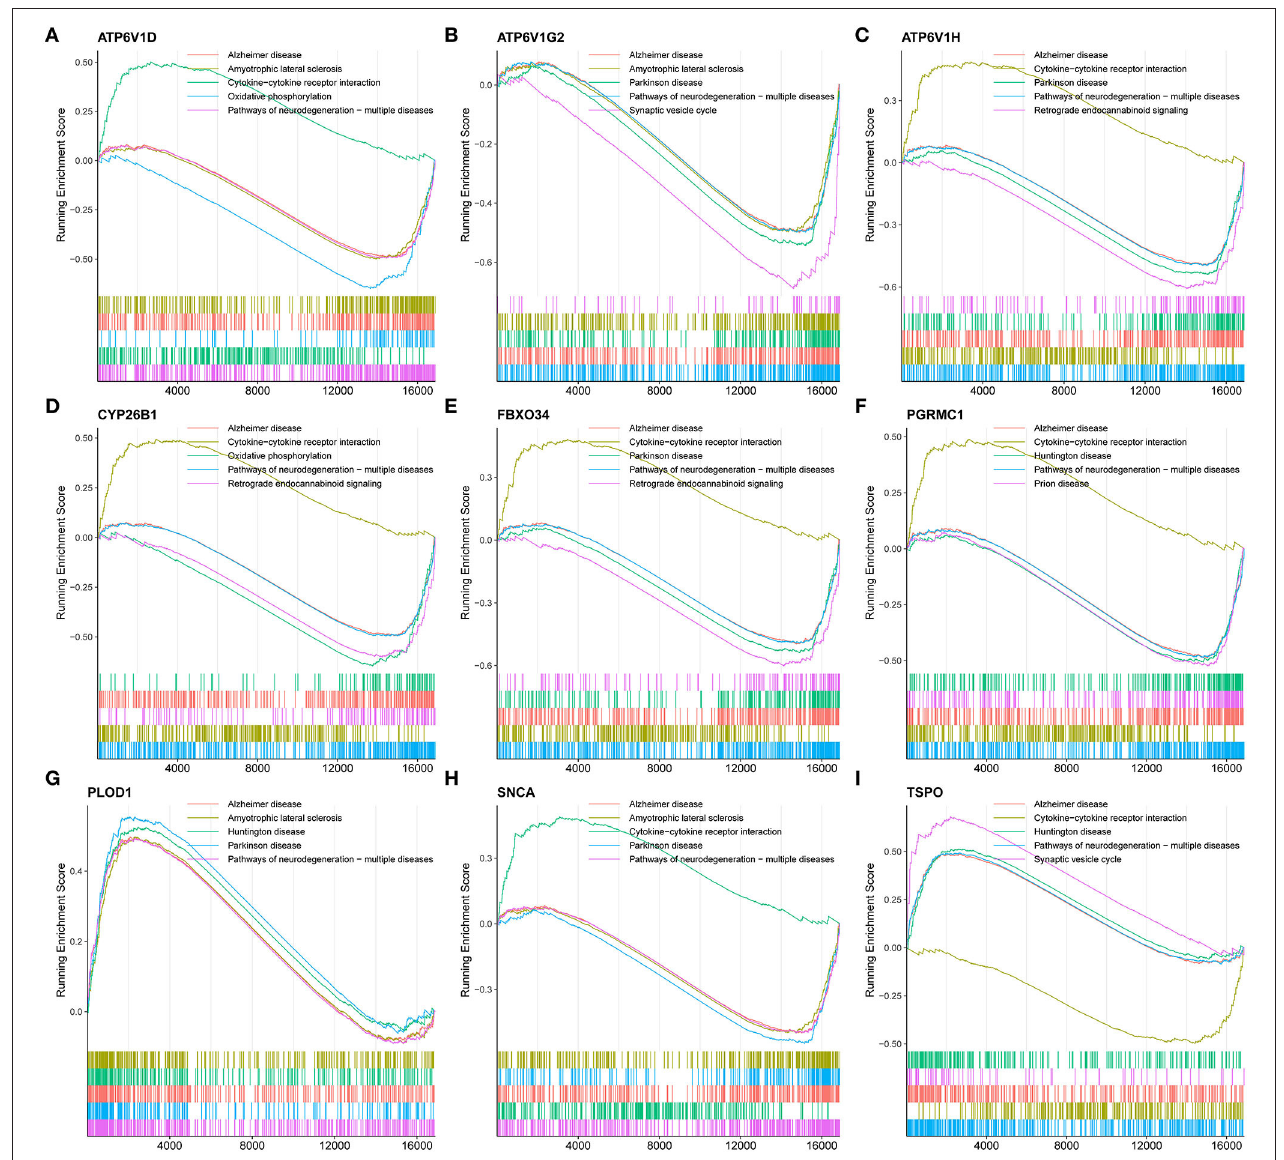
FIGURE 6 | GSEA revealed the enriched pathways of the hub genes. (A) ATP6V1D, (B) ATP6V1G2, (C) ATP6V1H, (D) CYP26B1, (E) FBXO34, (F) PGRMC1, (G) PLOD1, (H) SNCA, and (I)